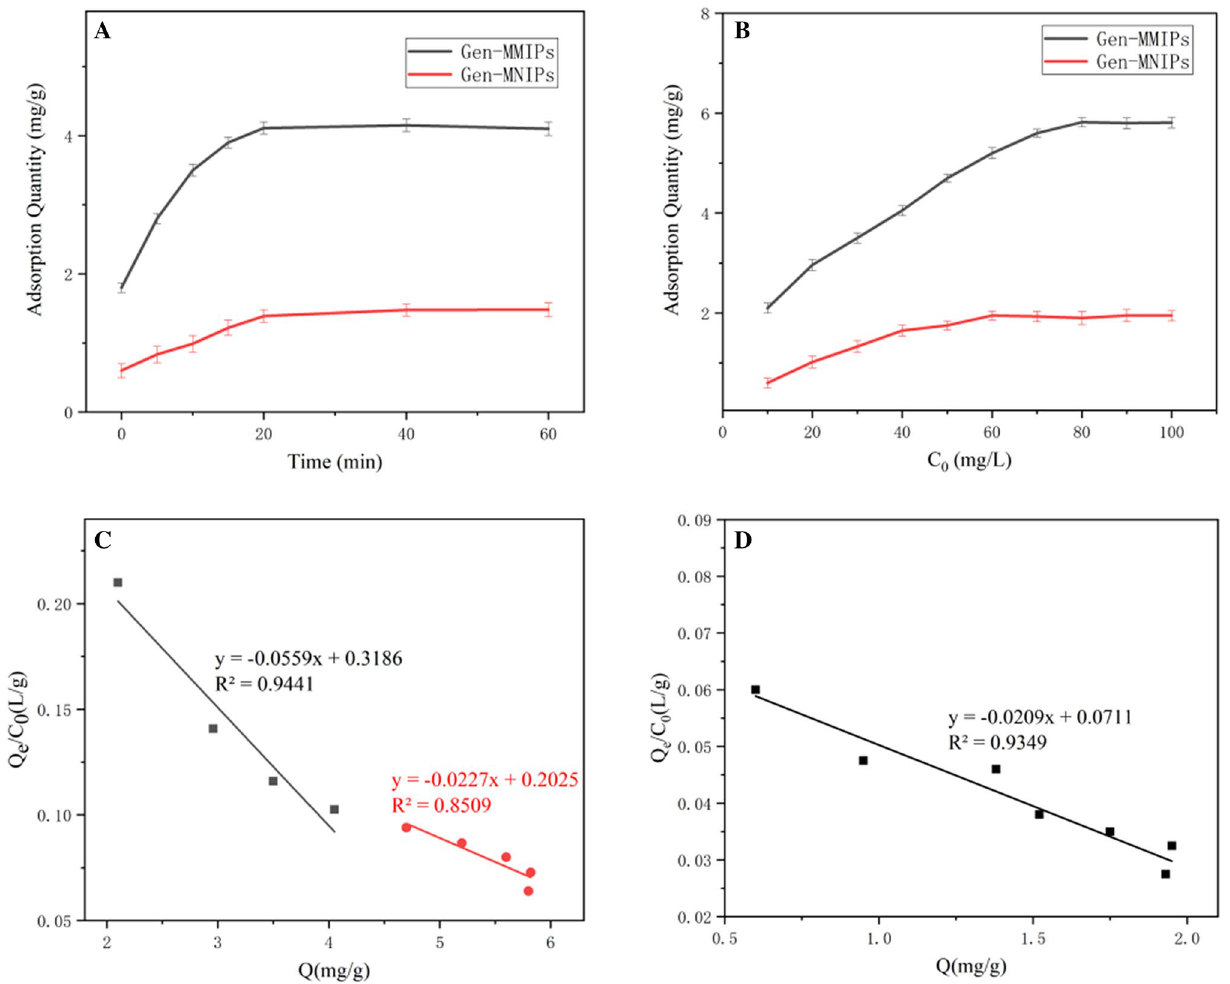
Figure 4. ( A ) Adsorption kinetic of Genistein on Gen-MMIPs and Gen-MNIPs, ( B ) adsorption isotherms of Genistein on Gen-MMIPs and Gen-MNIPs, ( C ) Scatchard plots of Gen-MMIPs and ( D ) Scatchard plots of Gen-